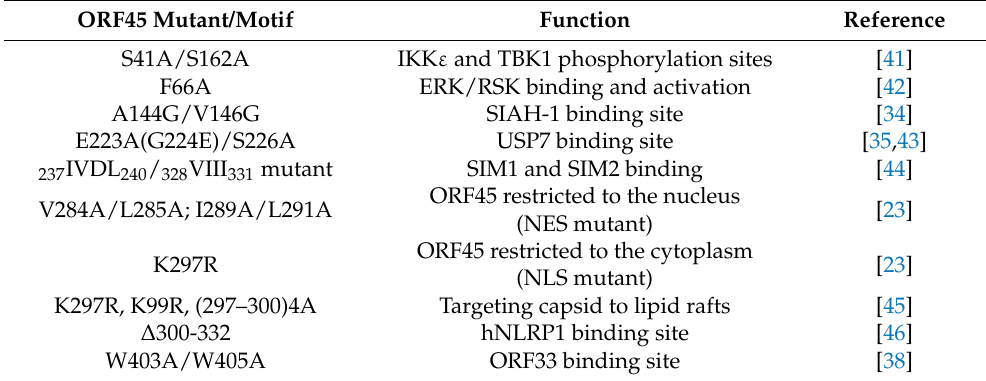
Table 1. Previously characterized ORF45